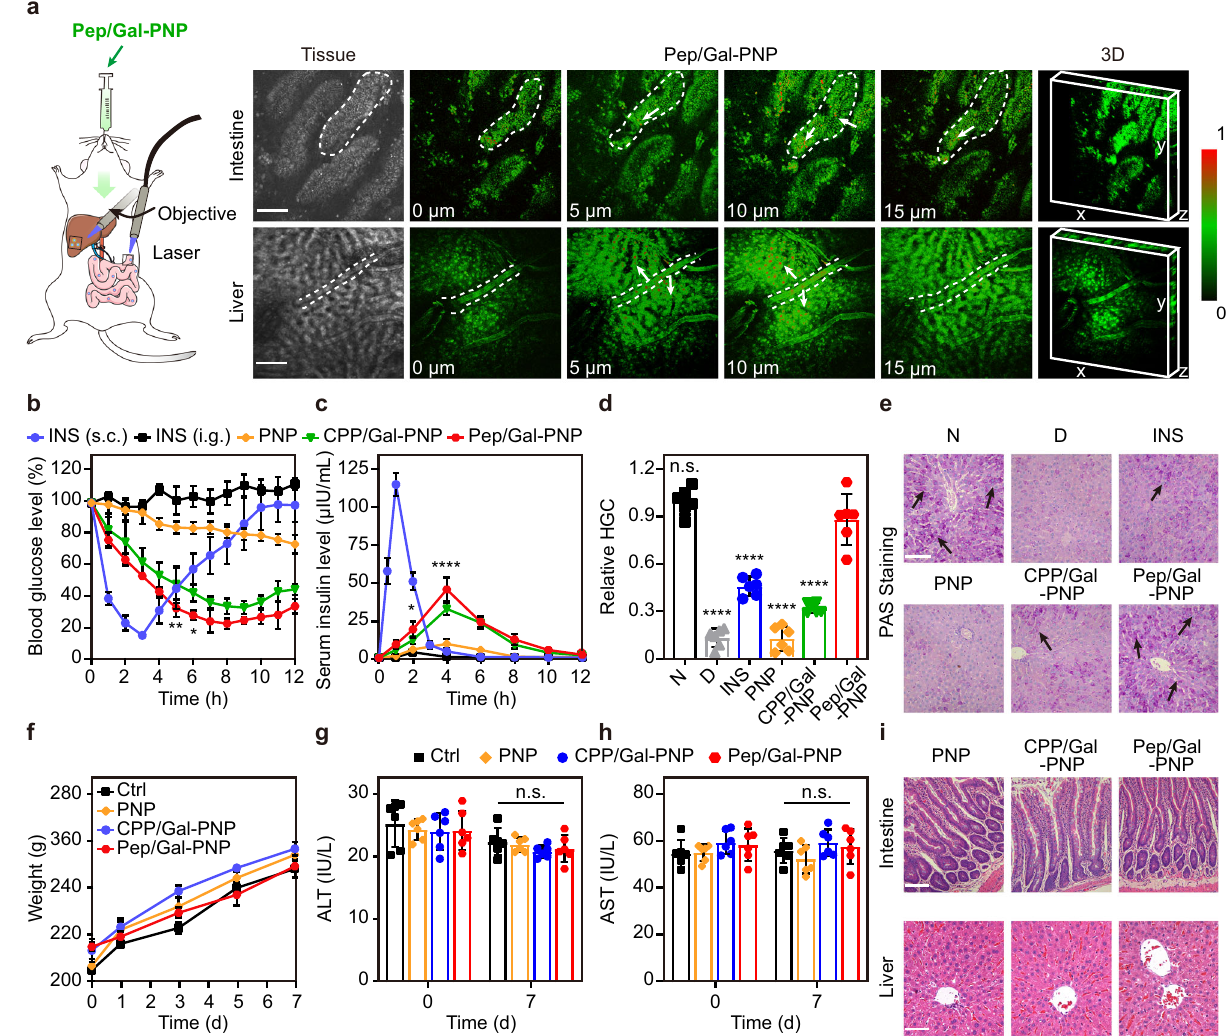
Fig. 6 | Invivotraf fi cking, hypoglycemic effects,and toxicity ofnanoparticles. a Confocal laser endomicroscopy (CLE) images of intestine villi (top row) and liver lobe (bottom row) from a rat after oral administration of FITC-labeled Pep/Gal- PNPs. Scale bar: 100 μ m. The color bar indicates the fl uorescence intensity (a.u.). b Blood glucose levels over time in type I diabetic rats treated with different for- mulations. Data are presented as the mean±SD ( n =6 biologically independent rats). ** p =0.0054 at 5h, * p =0.0129 at 6h compared with the CPP/Gal-PNP group, two-way analysis of variance (ANOVA) with Tukey ’ s post-hoc test. c Peripheral serum insulin levels over time in diabetic rats treated with different formulations. Data are presented as the mean±SD ( n =6 biologically independent rats). * p =0.0316at2h,**** p <0.0001at4hcomparedwiththeCPP/Gal-PNPgroup,two- way analysis of variance (ANOVA) with Tukey ’ s post-hoc test. d Relative